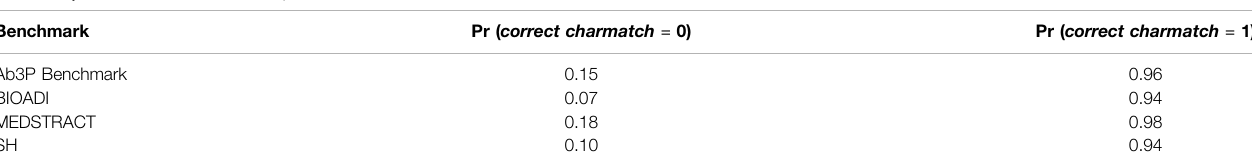
TABLE 6 | BERT-SQuAD does not capture charmatch .